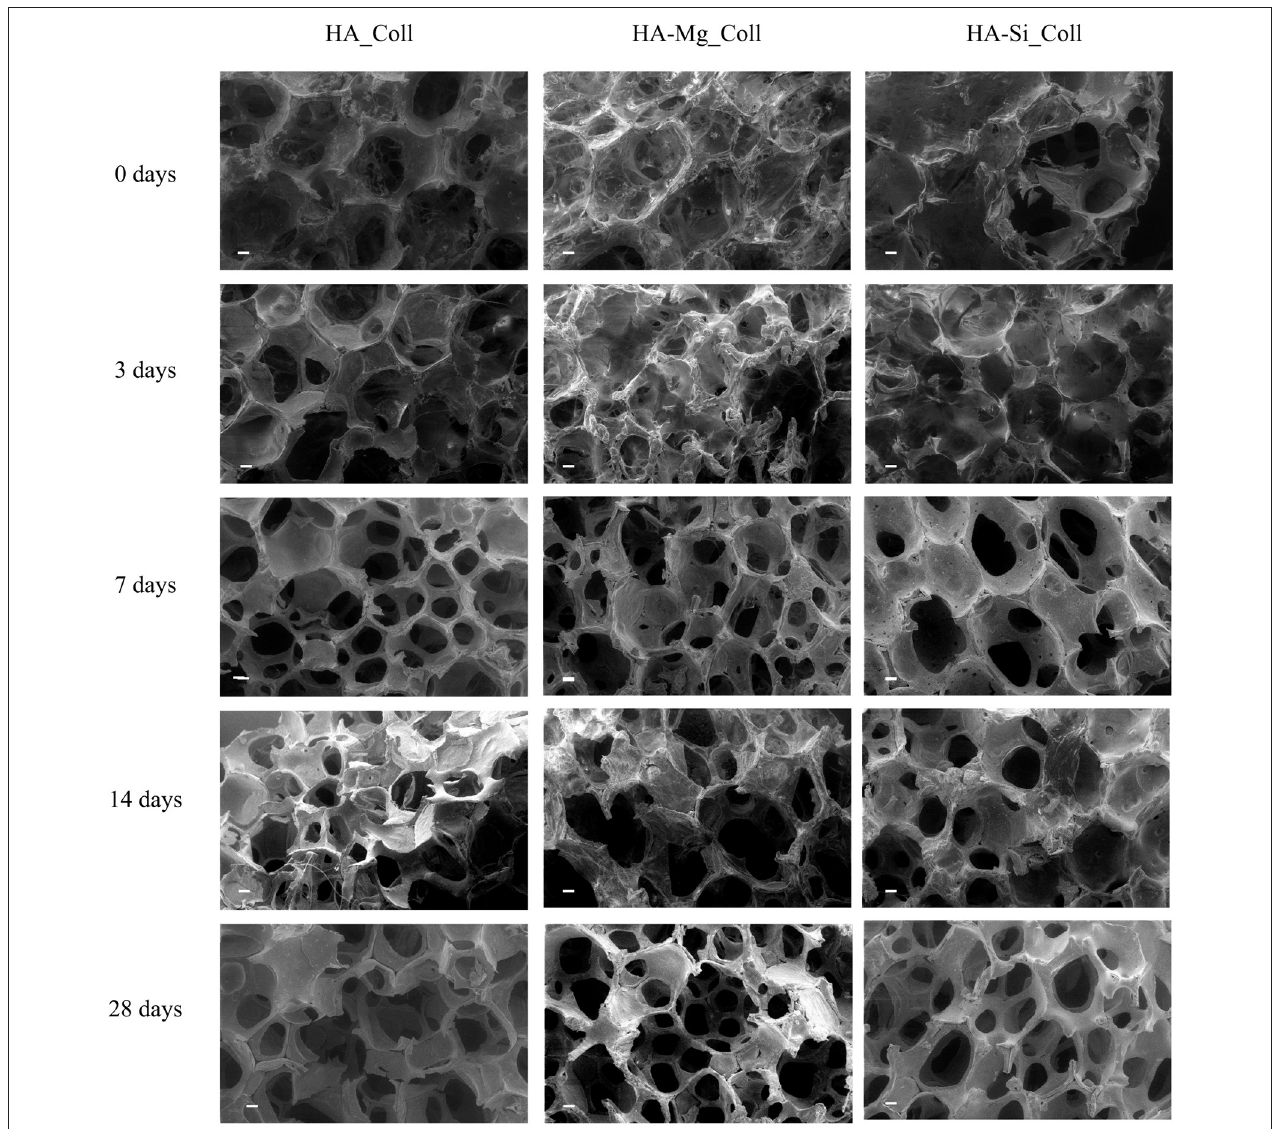
FIGURE 4 | SEM micrographs (scale bar: 200 µ m) of HA_Coll, HA-Mg_Coll, and HA-Si_Coll scaffolds after 0, 3, 7, 14, and 28 days in TRIS-HCl pH 7.4 at 37 ◦